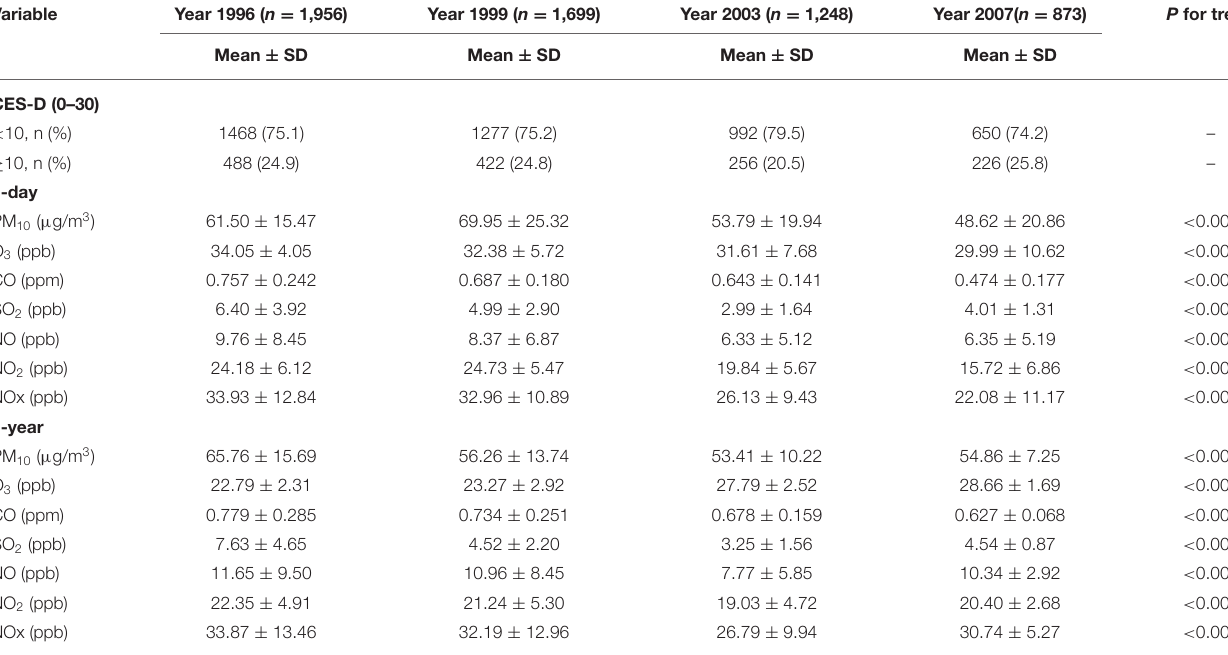
TABLE 2 | Distribution of depressive score and air pollutant concentrations over various exposure windows for each survey year.